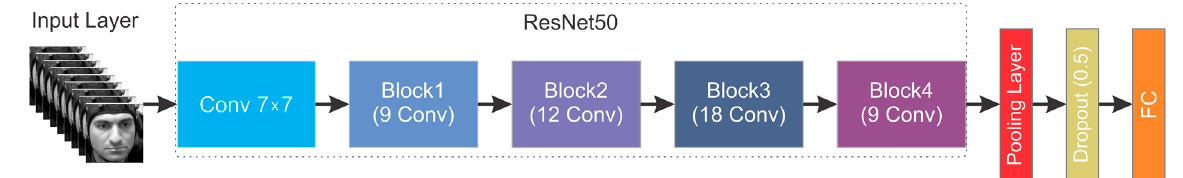
Figure 4. RestNet50-based CNN model for facial video clips (the facial image adopted from